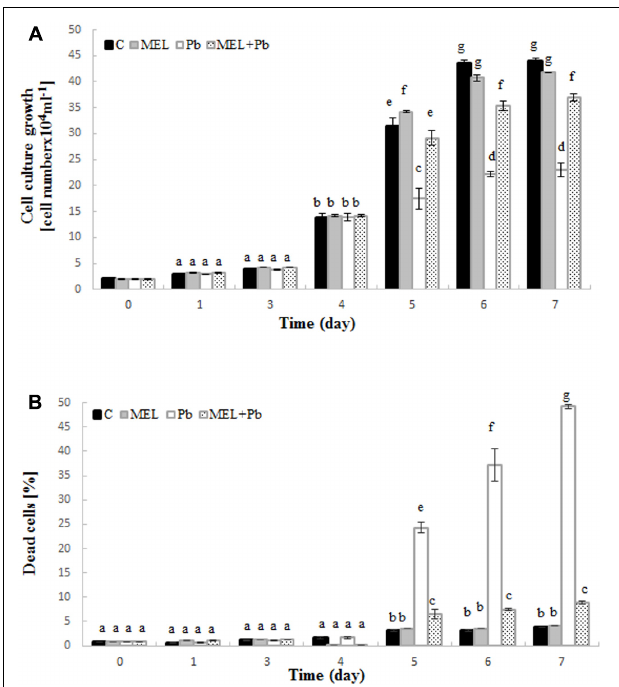
FIGURE 1 | Level of cell growth (A) and mortality (B) of BY-2 tobacco cells in conducted experiments. C, BY-2 cells cultured on LS medium – the control variant; MEL, BY-2 cells cultured on LS medium with 200 nM melatonin added from the beginning of the culture; Pb, BY-2 cells cultured on LS medium with 15 µ M Pb 2 + added on the 4th day of the culture and MEL + Pb, BY-2 cells cultured on LS medium with melatonin added from the start of the culture and with Pb 2 + added on the 4th day of culture. The results are expressed as mean values of 3 independent experiments ± SD. Two-way ANOVA and Duncan’s post hoc test were performed. The small letters next to the values show statistical significance p < 0.001. (A) Viability ANOVA results: Variant (C, MEL, Pb, MEL + Pb) F ( 3 ; 56 ) = 1189, p < 0.0001; Time (0, 1, 3, 4, 5, 6, 7) F ( 6 ; 56 ) = 11505, p < 0.0001; and interaction Variant × Time F ( 18 ; 56 ) = 270, p < 0.0001. (B) Mortality ANOVA results: Variant (C, MEL, Pb, MEL +